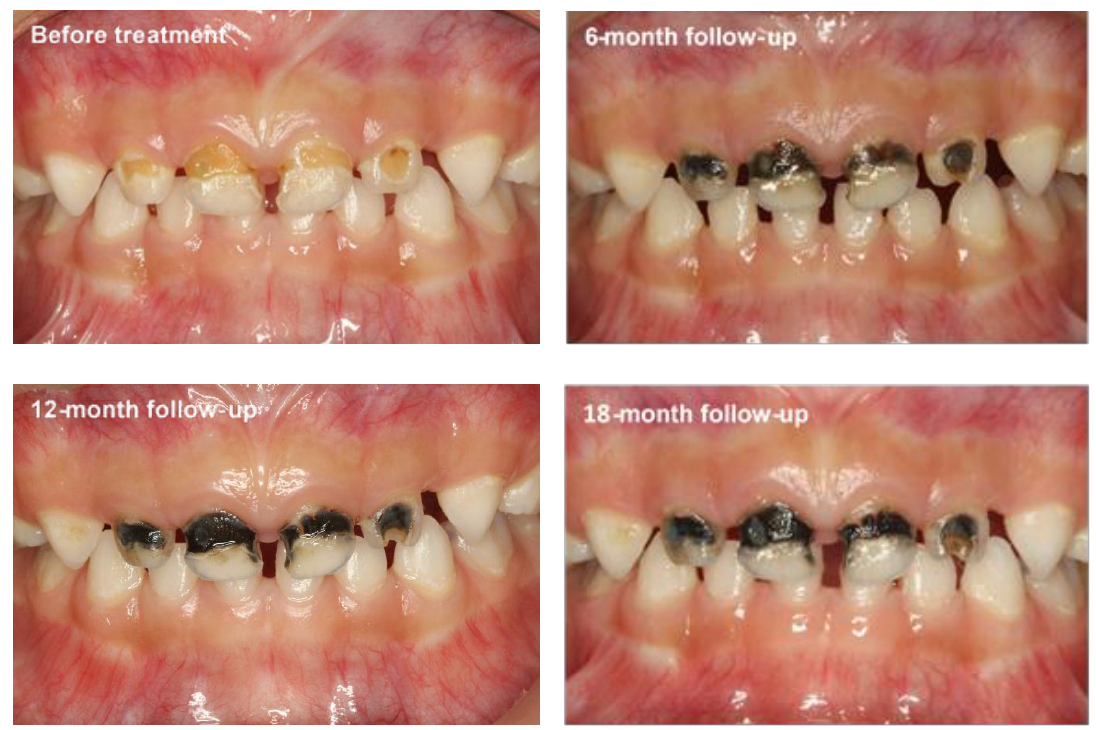
Figure 2. Dental caries before and after the application of 25% silver nitrate solution followed by 5% sodium fluoride varnish.